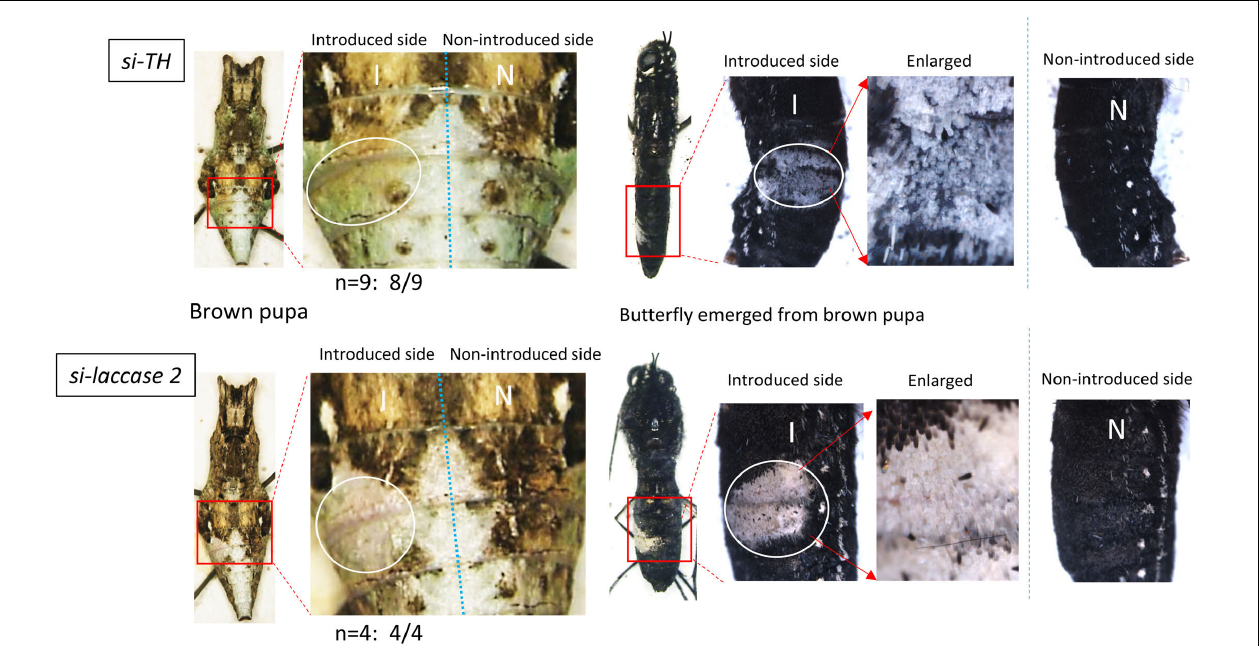
FIGURE 6 | Knockdown of TH and laccase 2 in brown-conditioned pre-pupae. By an electroporation-mediated method, we introduced siRNA for TH or laccase 2 into the left side of the fourth/fifth abdominal segments in pre-pupae after or just before gut purge. The white circle indicates the siRNA-introduced region. The right half of the body is the side into which siRNA was not introduced. Eight of nine pre-pupae treated with si-TH and four of four pre-pupae treated with si-laccase 2 showed the repression of brown coloration in the pupal stage (Left), and the loss of black pigmentation in the adult stage (Right). To clearly show the effects in butterflies, we removed their